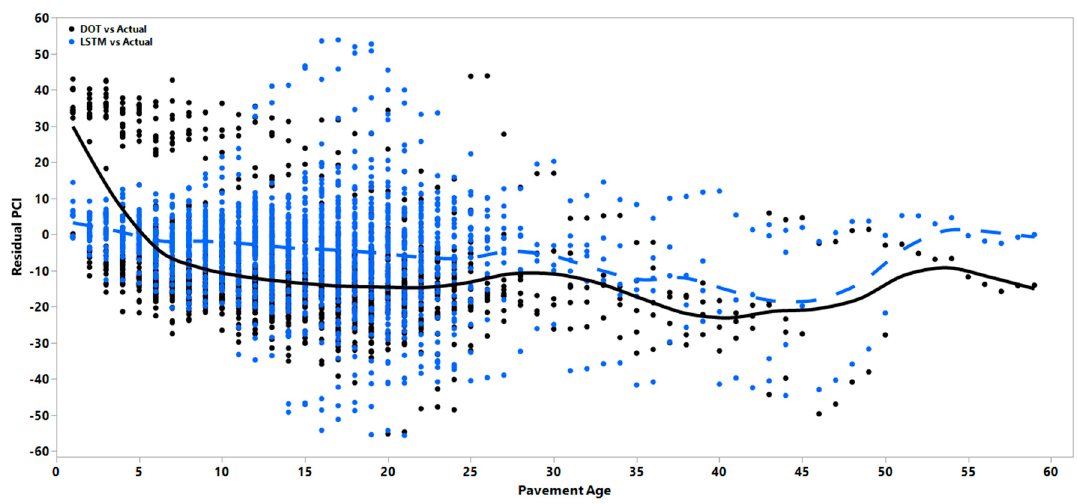
Figure 8. PCI residual vs. age in COM pavements.